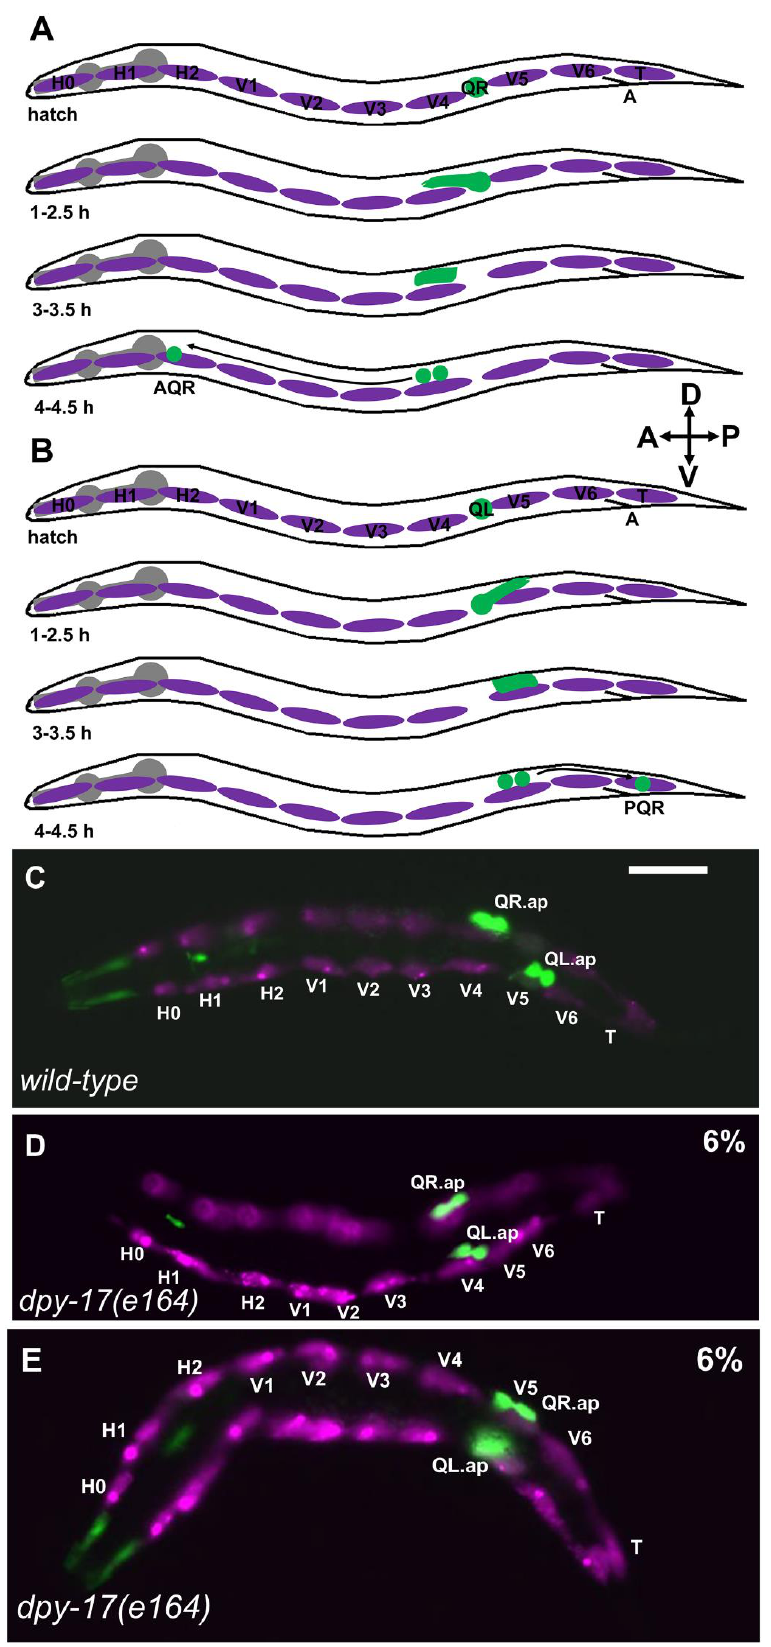
Figure 1. Q neuroblast migration . ( A ) A schematic representation of QR and descendant